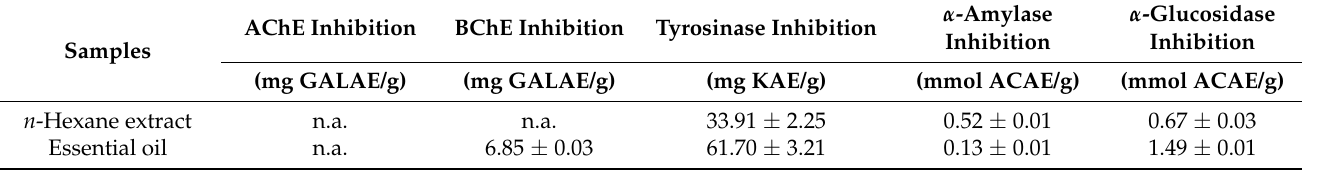
Table 3. Enzyme inhibitory effects of the n -hexane extract and the essential oil isolated from P. guajava